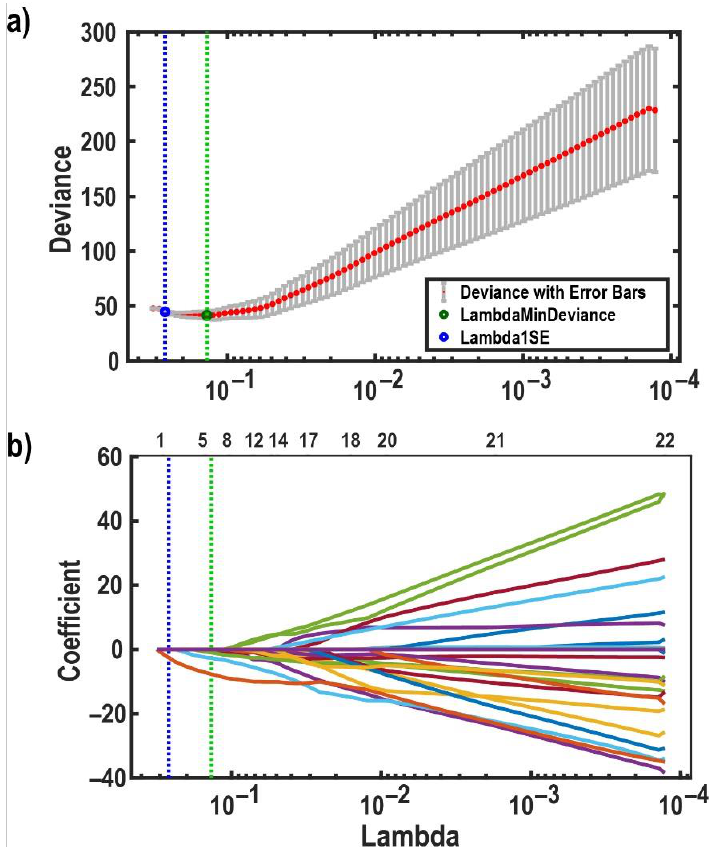
Figure 1. Effects of LASSO regularization tuning parameter λ on regression coefficients, and deviances. ( a ) A plot of the cross-validation deviance of the LASSO fit model against the λ . This figure shows leave-one-subject-out cross-validation results to determine the optimal value of λ . The Y -axis indicates the cross-validation deviance corresponds to the values of λ on the X -axis. The mean cross-validation deviance is shown by the red points in this figure, and each error bar shows ± 1 standard deviation. The blue and green vertical dotted lines (in both figures) indicate the λ , which gives the minimum deviance with no more than one standard deviation (blue circle) and the minimum deviance (green circle), respectively. ( b ) The paths of the LASSO fit model’s coefficients in dependence on λ . This figure shows how λ controls the shrinkage of LASSO coefficients. The numbers above the box show how many non-zero coefficients remain considering the corresponding λ values on the X -axis. The Y -axis illustrates the coefficients of classifiers. Each path refers to one regression coefficient. It is shown that when λ increases to the left side of the plot, the number of remaining non-zero coefficients gets close to zero.